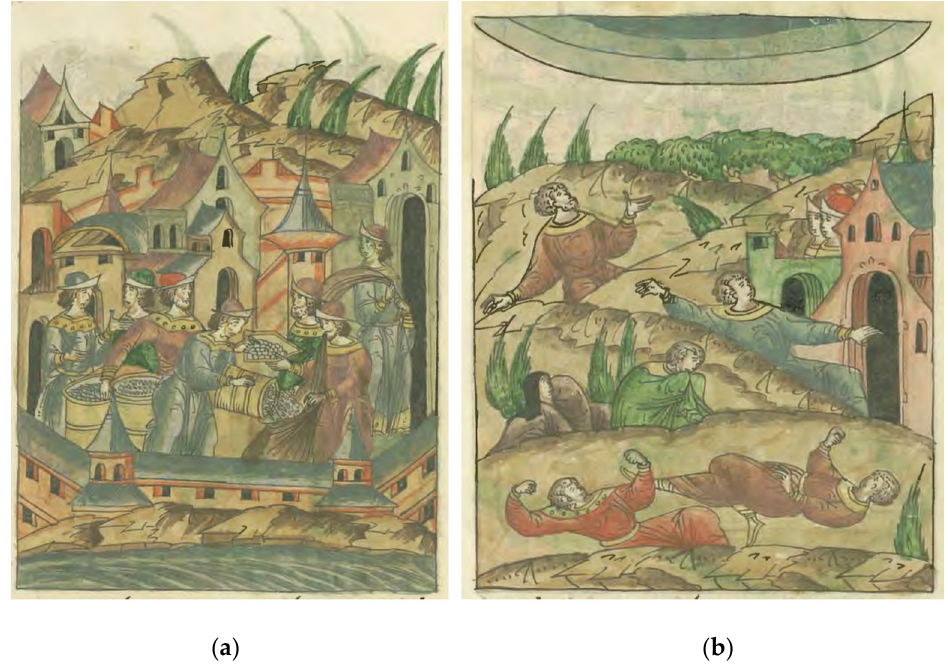
Figure 2. Subsistence crises in Novgorod. ( a ) Crop failure, 1412; ( b ) plague, 1417. The Illustrated Chronicle of Ivan the Terrible , Osterman Volume II . Library of the Russian Academy of Sciences.